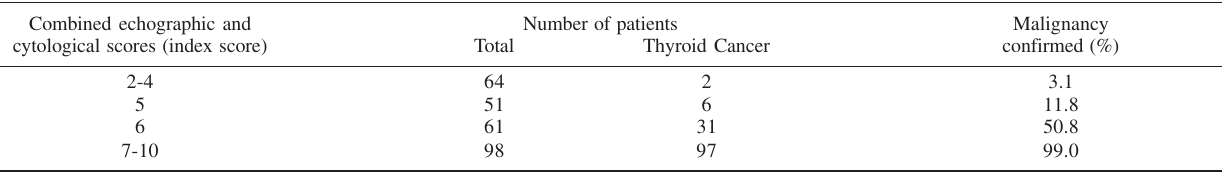
Table 2 -Thyroid cancer prevalence in patients with thyroid nodules who underwent thyroid surgery (n = 274). Combined echographic